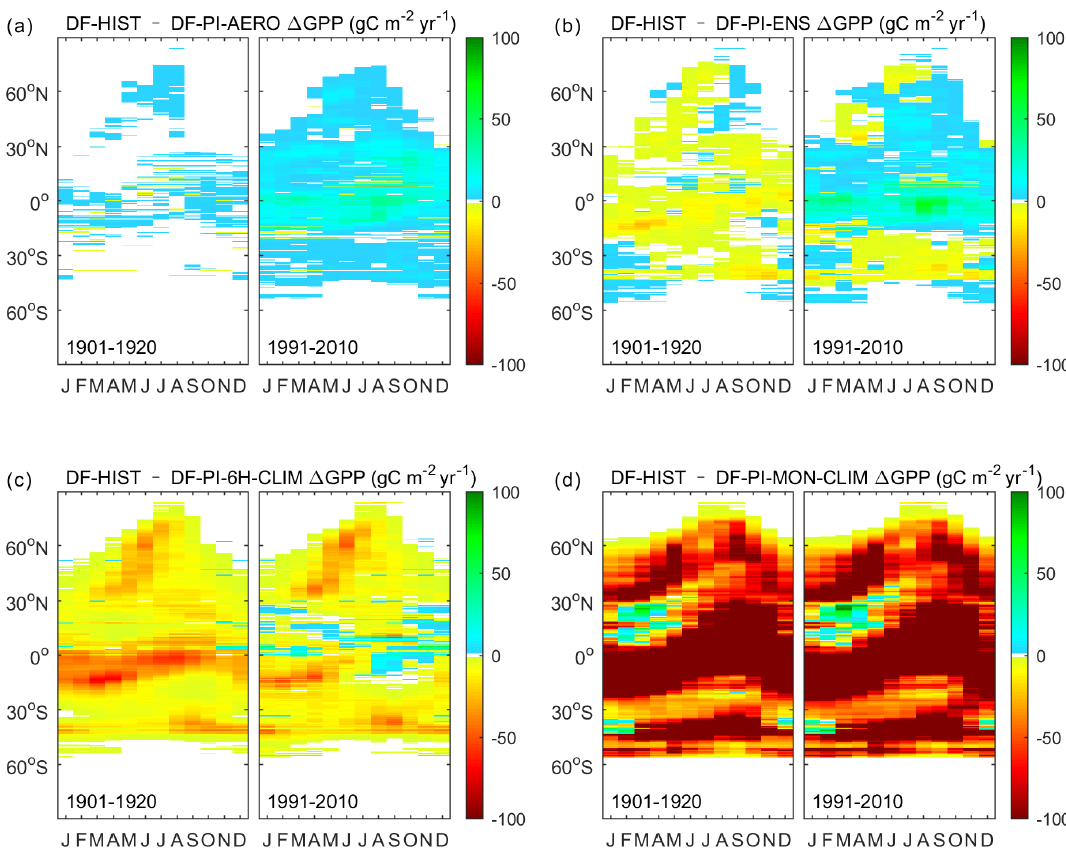
Figure 4. Seasonal variations of (cid:49) GPP in gCm − 2 yr − 1 between DF-HIST and (a) DF-PI-AERO, (b) DF-PI-ENS, (c) DF-PI-6H-CLIM and (d) DF-PI-MON-CLIM during 1901–1920 and 1991–2010.